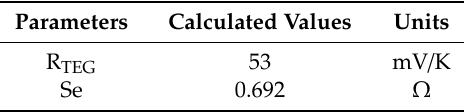
Figure 4. Open circuit testing: V OC vs Temperature gradients. Table 3. Calculated parameters for TEC1-12722.